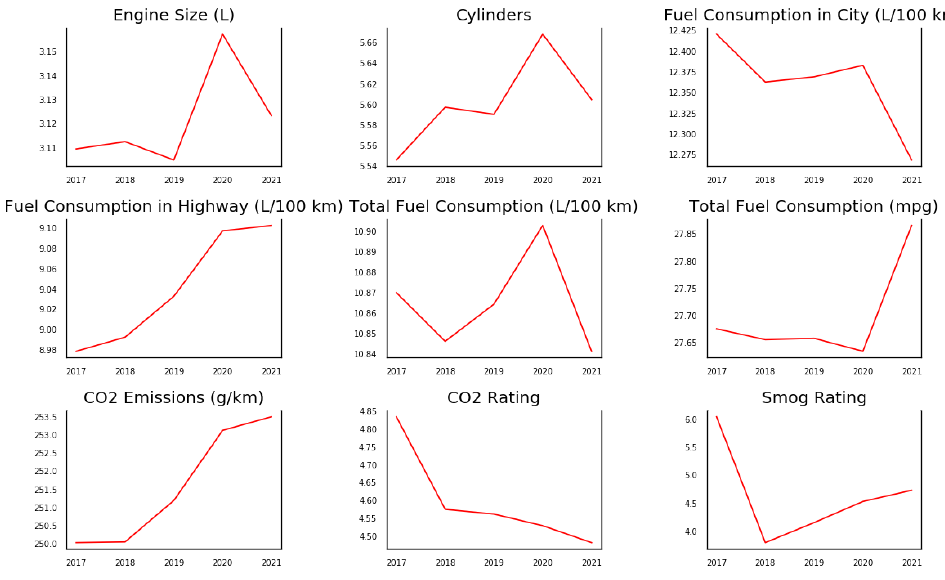
Figure 16. All input metrics over time.